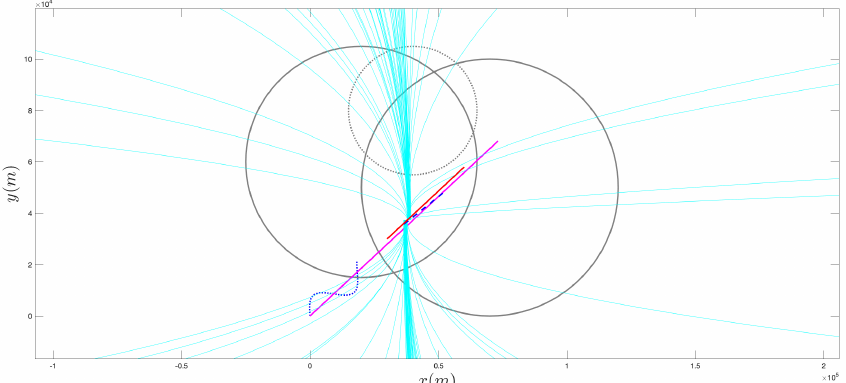
Figure 7. Zoomed version of a portion of Figure 6.